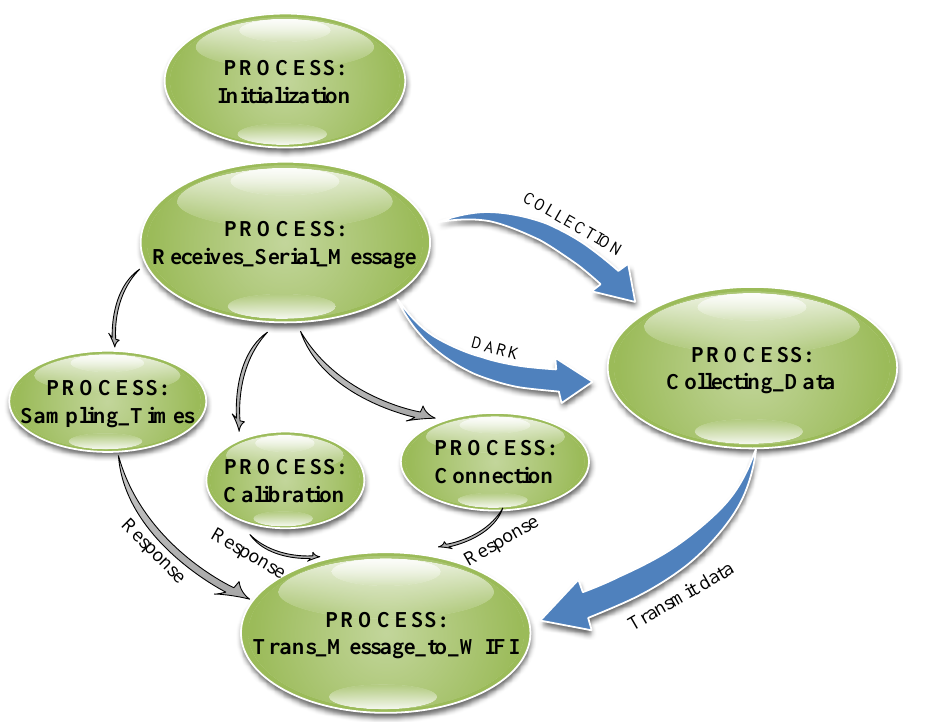
Figure 10. Processes of the software system.